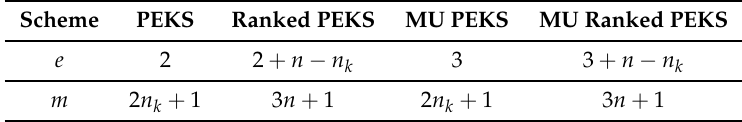
Table 2. The efficiency of the trapdoor phase.